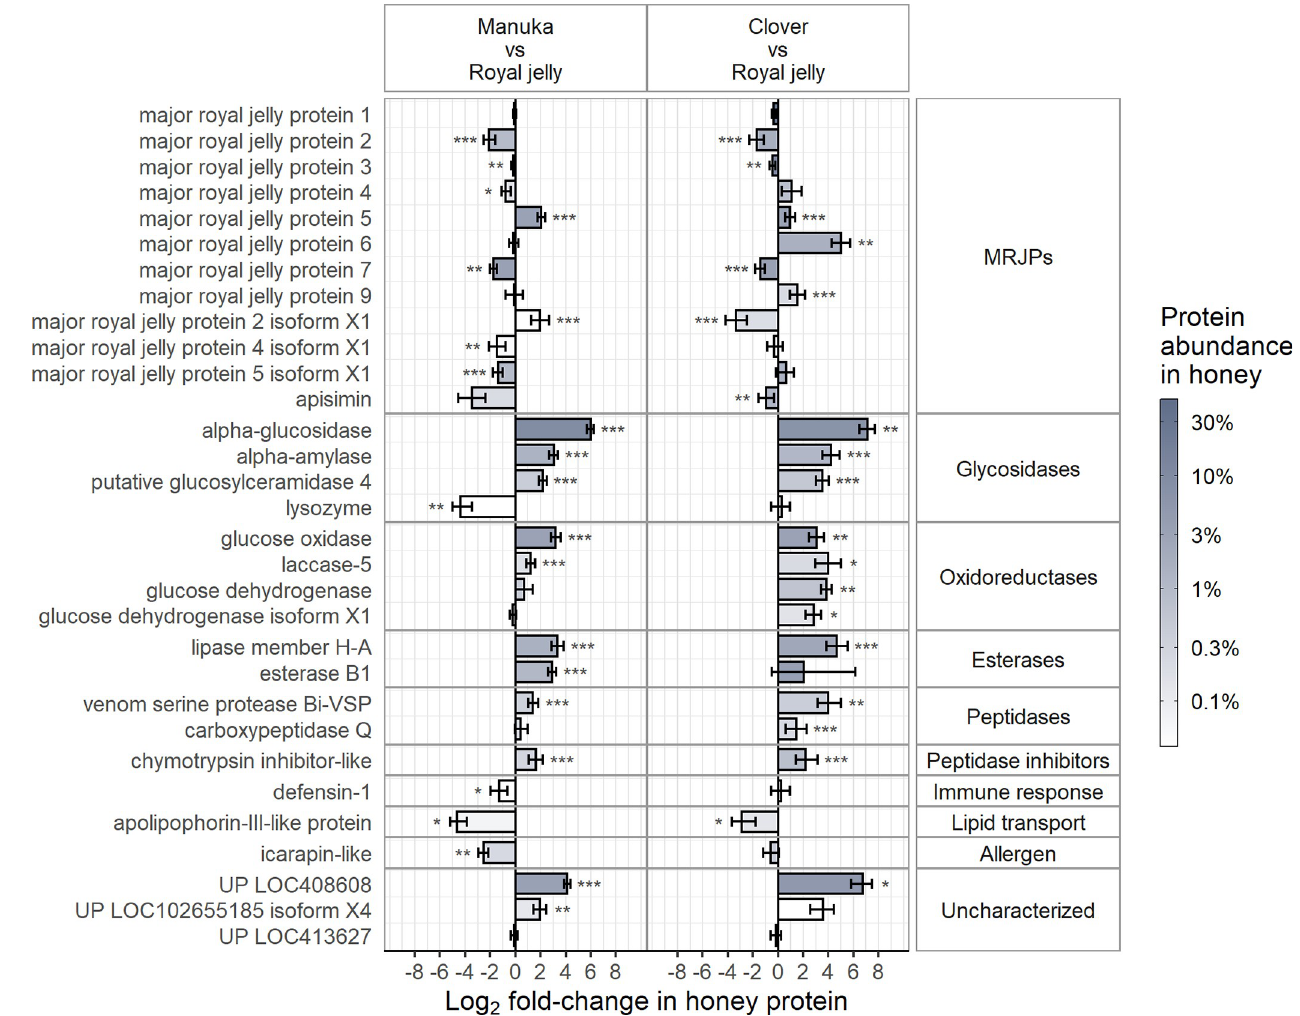
Fig 2. Comparative analyses of m ā nuka and clover honey to royal jelly by SWATH-MS. Quantitative comparisons of proteins identified by both analysis methods, expressed as the log 2 -fold change in sum of peak intensities for each honey protein compared to the corresponding protein found in royal jelly. Apisimin was added from the SWATH-MS analysis, giving 32 proteins in total. The shading of the bars represents the mean peptide intensity of protein in the honey samples (m ā nuka, n = 12; clover, n = 6, royal jelly n = 8). Significant differences are indicated by � P < 0.05, �� P < 0.01, ��� P <